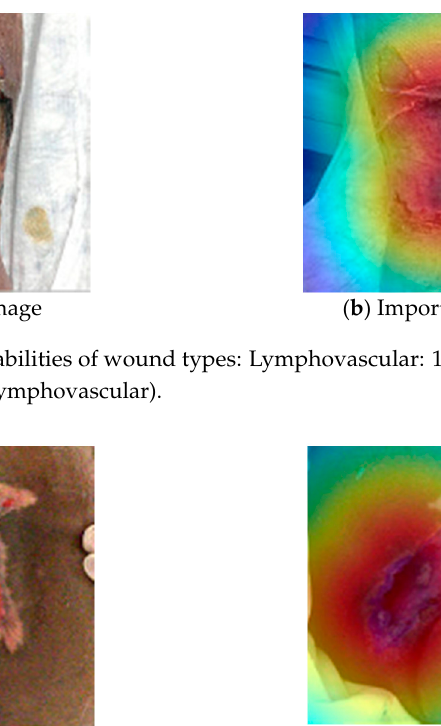
Figure 5. The probabilities of wound types: Diabetic: 95.36%, pressure injury: 4.07%, lymphovascu- lar: 0.01%, surgical: 0.55% (Diabetic).